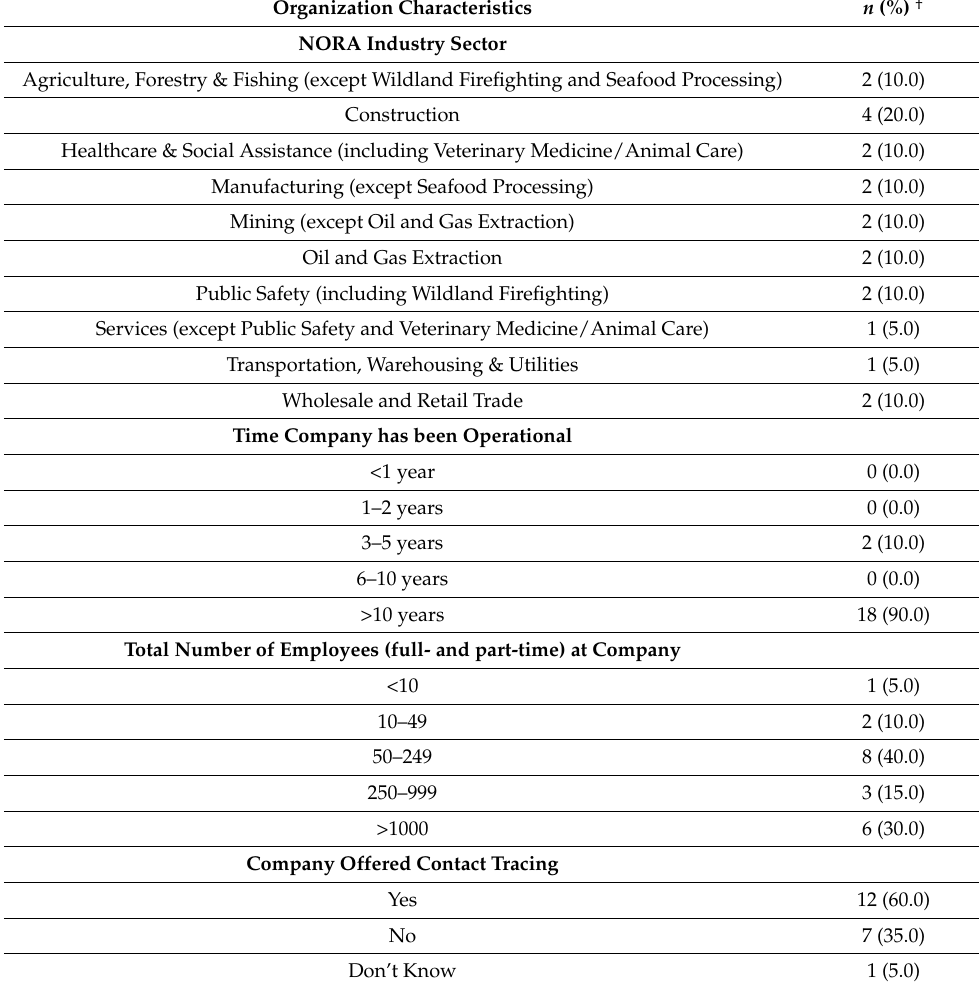
Table 1. Organization/company characteristics and SARS-CoV-2 Testing Practices among U.S. com- panies participating in the Employer Testing of SARS-CoV-2 History (ETCH) Phase 1 Study, January– April 2021 ( n =